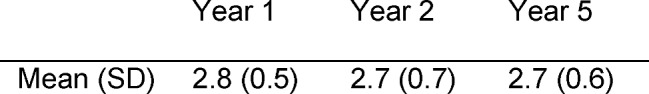
Subjective preparedness to make a judgment in this scenario (1=very good, 4= very poor)